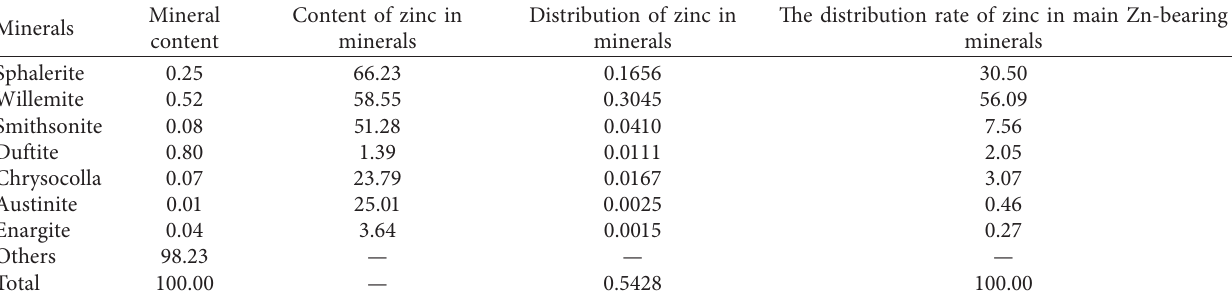
Table 10: Distribution of zinc in main Zn-bearing minerals